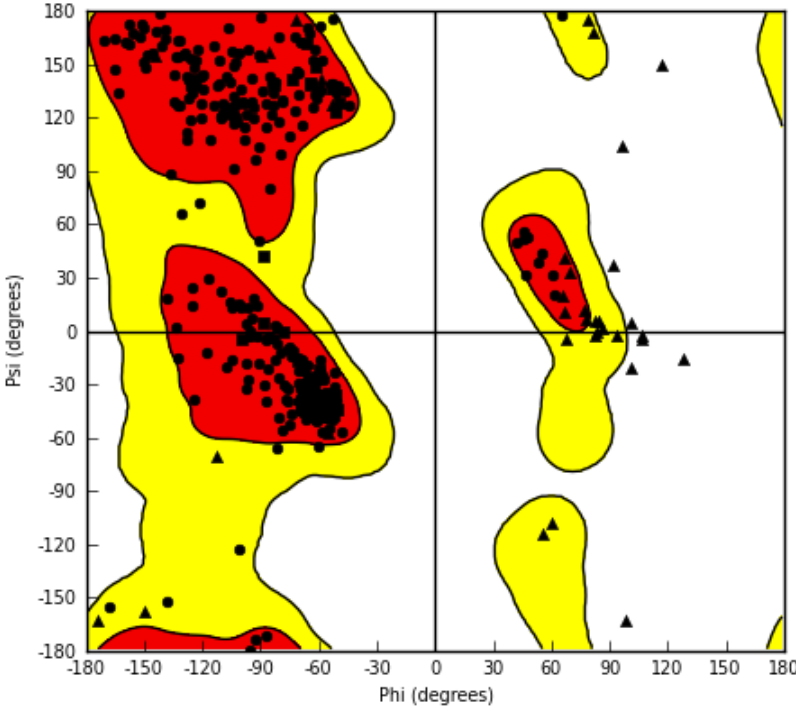
Figure S1. Ramachandran plot of Mycobacterium tuberculosis AlaR enzyme (PDB ID: